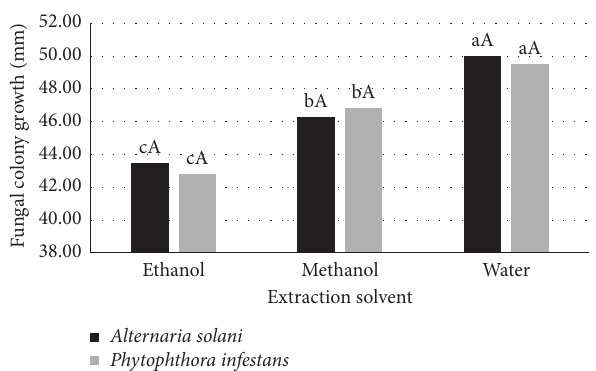
Figure 1: Comparative effect of extraction solvent of crude extracts on their efficacy against the fungal pathogens at day 7. Means with the same lowercase letter on different extraction solvents are not significantly different while those with the same upper case letter on the same extraction solvent are not significantly different at p � 0 .